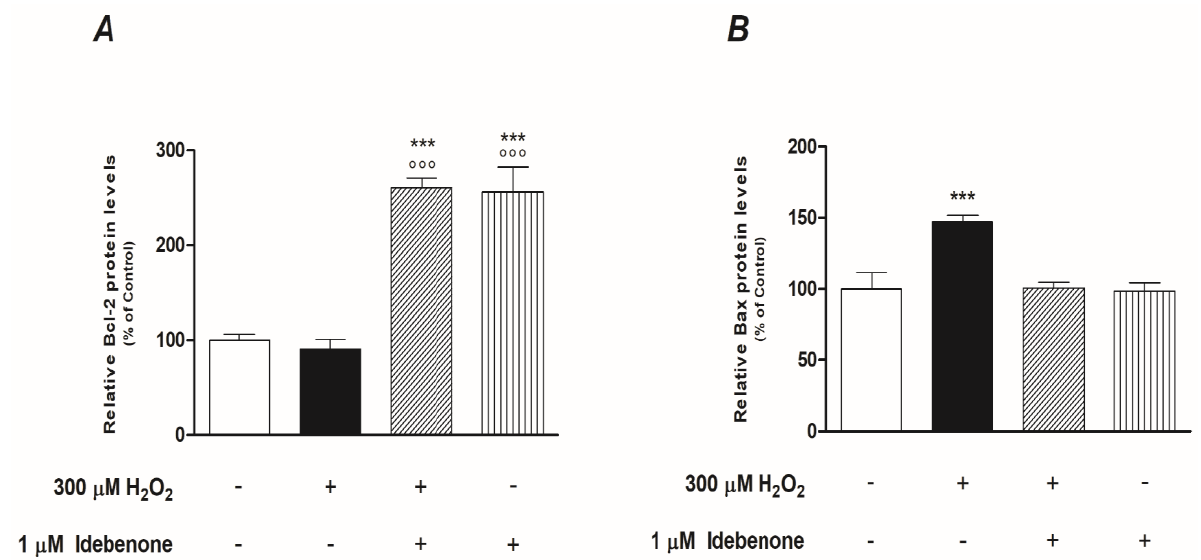
Figure 3. Idebenone effect on the protein levels of Bcl-2 and Bax. Idebenone pre-treatment promotes Bcl-2 expression ( A ) but inhibits Bax expression ( B ) after H 2 O 2 induced oxidative stress for 24 h. Both histograms represent the means ± SEM of two independent experiments performed in quadruplicate (eight replicates per experimental group). *** p < 0.001 vs. control; ◦◦◦ p < 0.001 vs. H 2 O 2 alone.